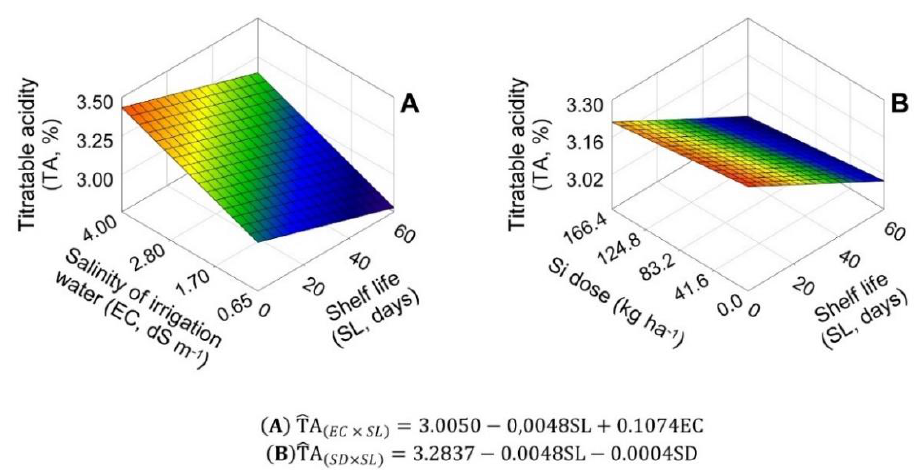
Figure 6. Unfolding of the treatment factors of salinity of irrigation water (EC) ( A ) and silicon dose (Si) ( B ), with shelf life (SL), for the variable titratable acidity (TA, %), in ‘Rio da Antas’ onion bulbs.